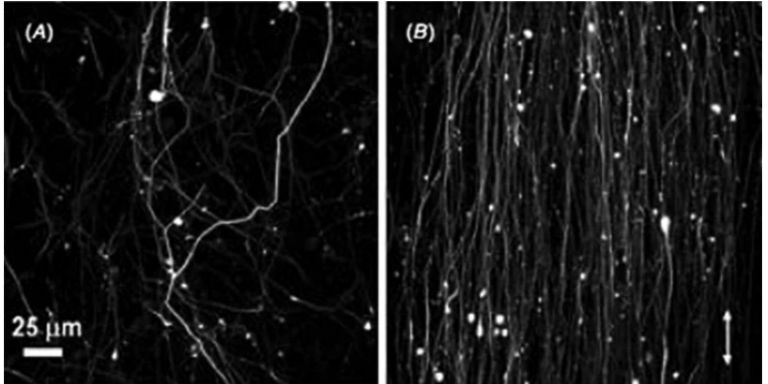
Figure 29. High-magnification confocal microscopy images of neurite morphology on (A) random and (B) aligned surface modified PLLA nanofibers with BFGF. Neurites oriented in the direction of aligned nanofibers while more neurite branching on random nanofibers was seen. Reproduced from [196] with permission of American Chemical Society.